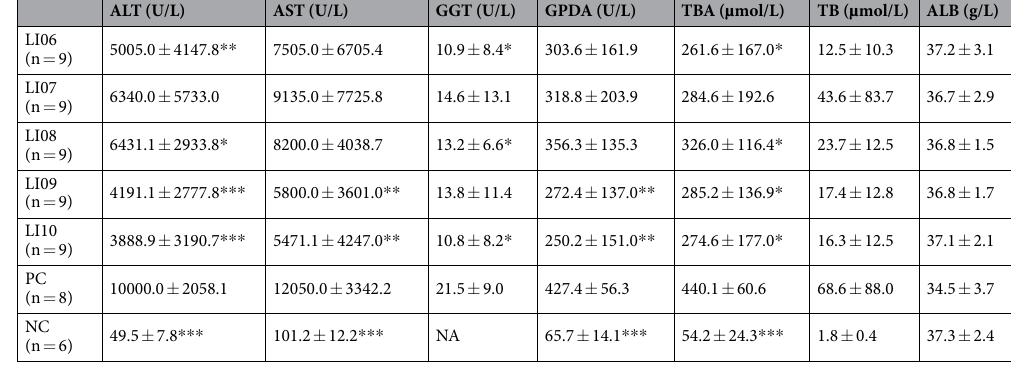
Table 1. Effects of pretreatment with five Bifidobacterium strains on liver function during D-GalN-induced acute liver injury. Values are expressed as the mean ± SD. The serum levels of aspartate aminotransferase (AST), alanine aminotransferase (ALT), glutamyltransferase (GGT), glycylproline dipeptidyl aminopeptidase (GPDA), total bile acid (TBA), total bilirubin (TB) and albumin (ALB) were determined after 24 h of D-galactosamine (D-GalN) administration. Compared with the PC group, * p < 0.05, ** p < 0.01, *** p <